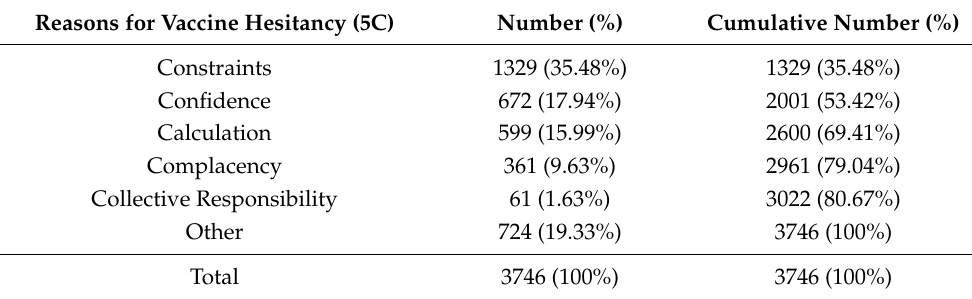
Table 2. Reasons for COVID-19 Vaccine